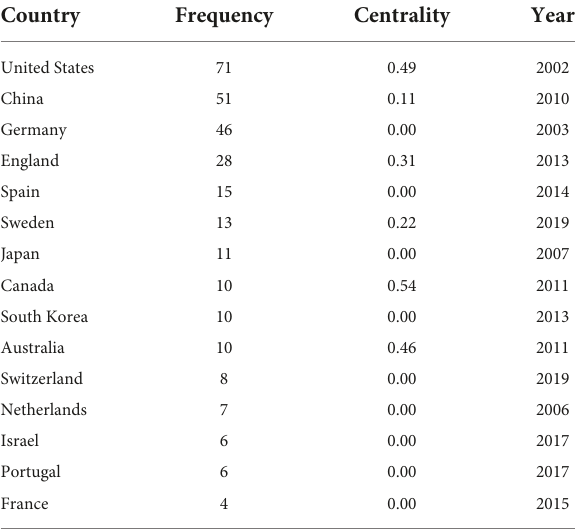
TABLE 4 Top 15 countries for the number of